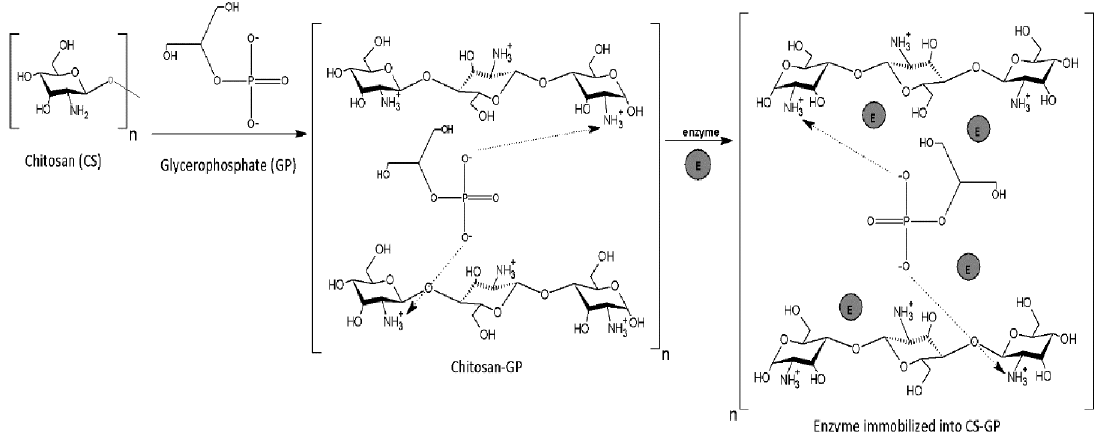
Figure 1. Hypotetic representation of CS-GP matrix formation and lipase immobilization by physical